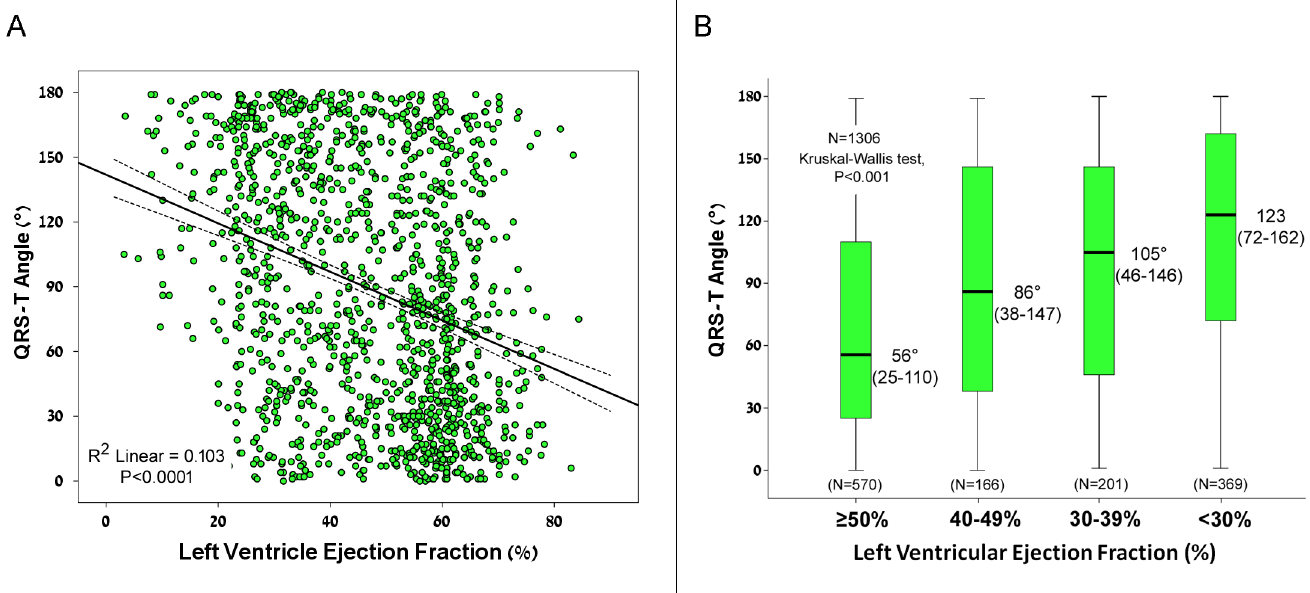
Fig 4. Relation between QRS-T angle and left ventricular systolic function. (A) Scatter plot demonstrating an inverse linear relation between QRS-T angle and left ventricular ejection fraction. Linear regression: R 2 = 0.103, B = -1.06, Standard error 0.11, P < 0.0001. (B) Box plot of the median QRS-T angle stratified according to the left ventricular ejection fraction. Median QRS-T angle was wider with reduction in left ventricular ejection fraction (Kruskal Wallis test; P < 0.001). Box plots denote median and inter-quartile range (IQR); whiskers are of maximum 1.5